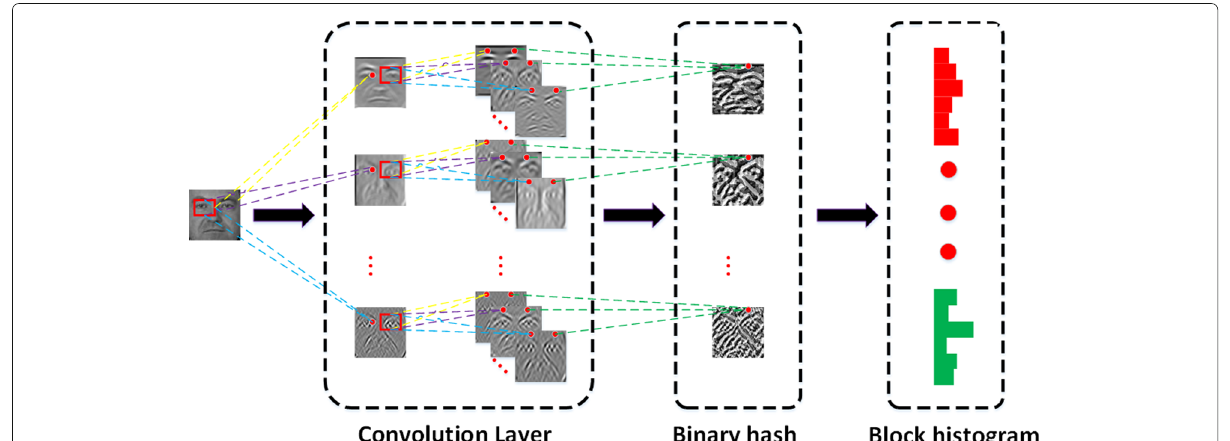
Fig. 1 ICANet architecture ICANet consists of three parts: (1) two-phase convolutional layer, (2) binary hash, and (3) block